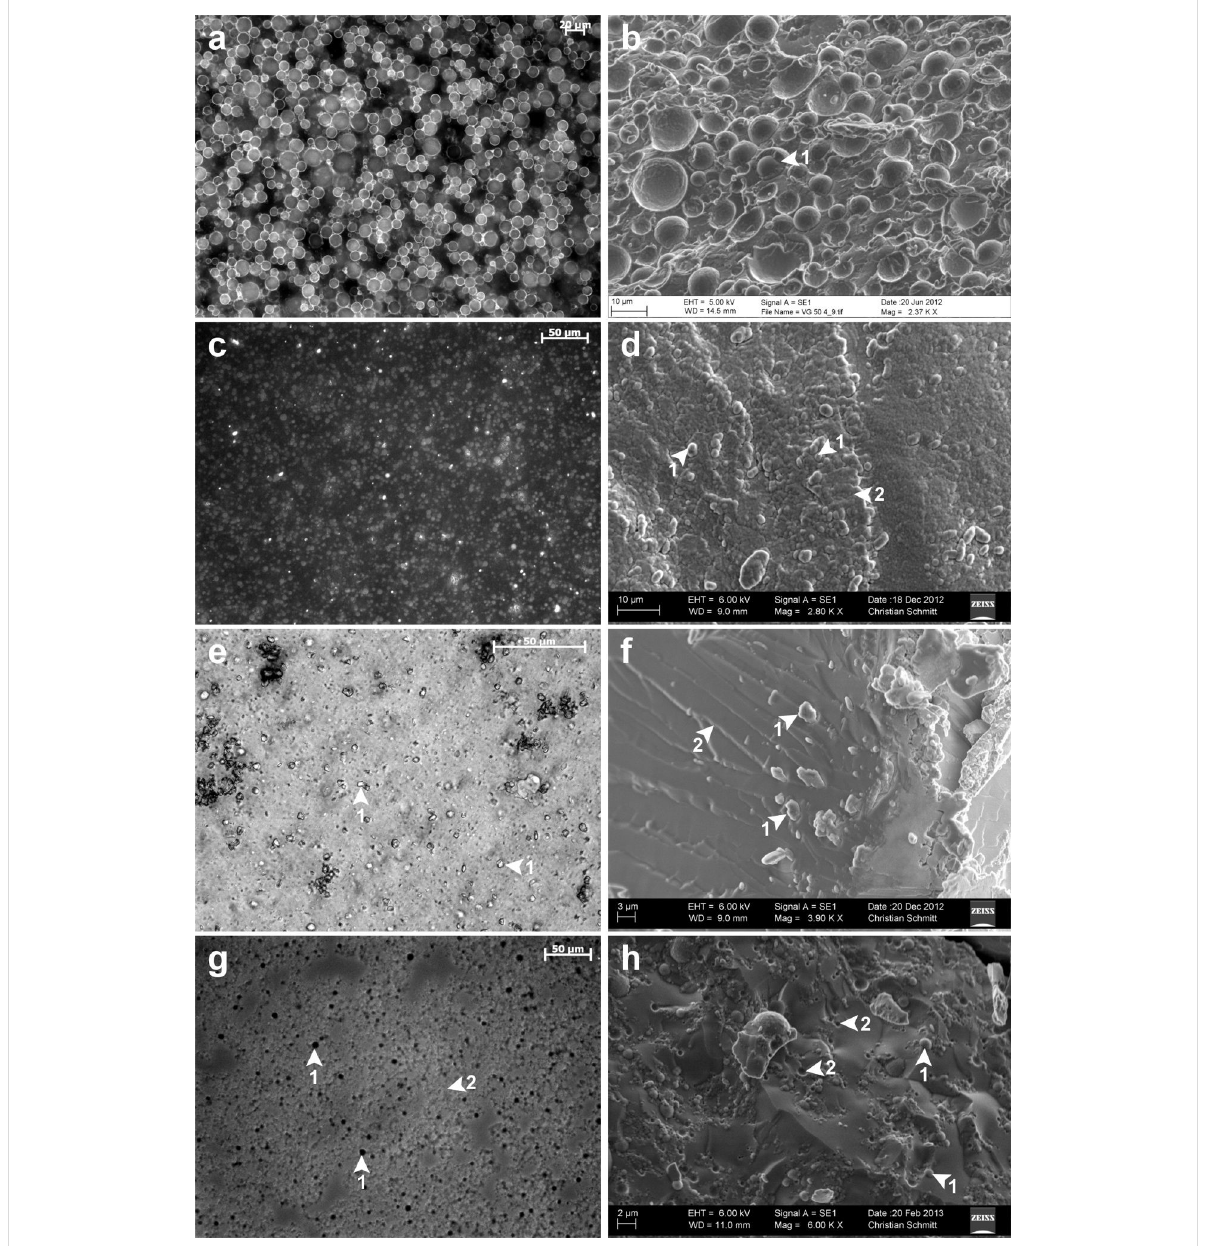
Figure 1: Droplet distribution of selected emulsions of the first and second generation. Left side: appearance of the emulsions under bright field light or fluorescence microscopy; right side: appearance of the emulsions under cryo-SEM. (a) Densely distributed fluorescent lipid droplets of emulsion VG50 (Sudan-III-stained emulsion was examined under light excitation of 300–400 nm). The fluorescent droplets are indicative of the o/w character- istic of this emulsion, because these fluorescent oily droplets form the inner phase. The outer hydrophilic phase is reduced because of evaporation. (b) Embedded, densely distributed droplets of emulsion VG50 surrounded by a slightly textured boundary layer (arrow 1). The emulsion has a droplet size range of about <1–50 μ m, whereas most of the droplets lie between 5–15 µm. (c) Densely distributed fluorescent lipid droplets of the emulsion SG2 (Sudan-III-stained emulsion was examined under light excitation of 530–560 nm). The fluorescent droplets are indicative of the o/w character- istic of emulsion SG2, because these fluorescent oily droplets form the inner phase. (d) Distributed droplets (1) of emulsion SG2 embedded in an outer phase (2) with a rough appearance having a flaked structure. Main size range of round- to oval-shaped droplets is about <1–5 µm. (e) Loosely scattered and polyhedral droplets (1) of emulsion OA2 by light microscopy. The emulsion was examined under bright field after dilution with water. The lipid phase octacosane (1) consisted of solid polyhedral fragments causing aggregation. (f) Polyhedral fragments (1) of emulsion OA2 embedded in a lamellar-layered outer phase (2). Main size range of fragments is about <1–3 µm. (g) Non-fluorescent droplets (1) of emulsion SA4 embedded in a fluorescent outer phase (2) (the Sudan-III-stained emulsion was examined under light excitation of 530–560 nm). The non-fluorescent droplets in combination with the fluorescent outer phase are indicative of a w/o emulsion. (h) Smooth emulsion surface of SA4 consisting of both droplets (1) and cavities (2). The cavities (<1–2 µm) seem to represent the remains of evaporated water droplets following the sublimation step, whereas the unaf- fected droplets probably represent those that have not fully evaporated. Main size range of visible droplets is about 1–4